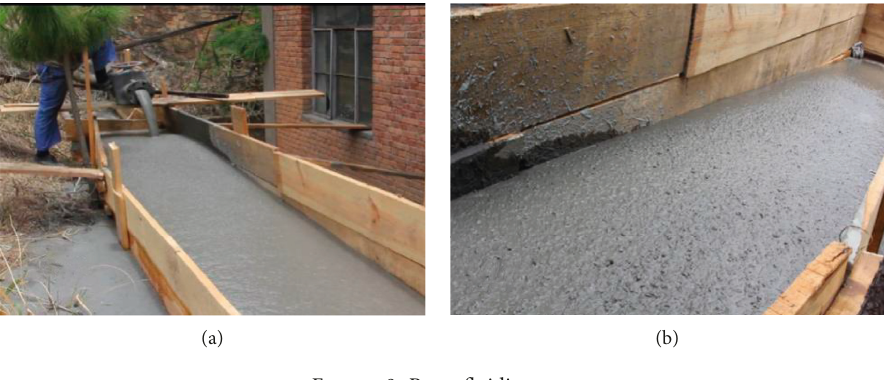
Figure 9: Paste fluidity Table 8: Results of the paste fluidity test.